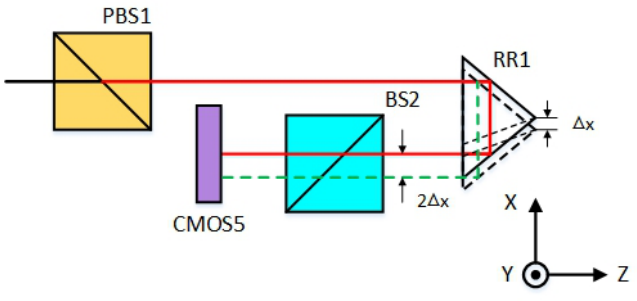
Figure 3. Measurement principle of straightness